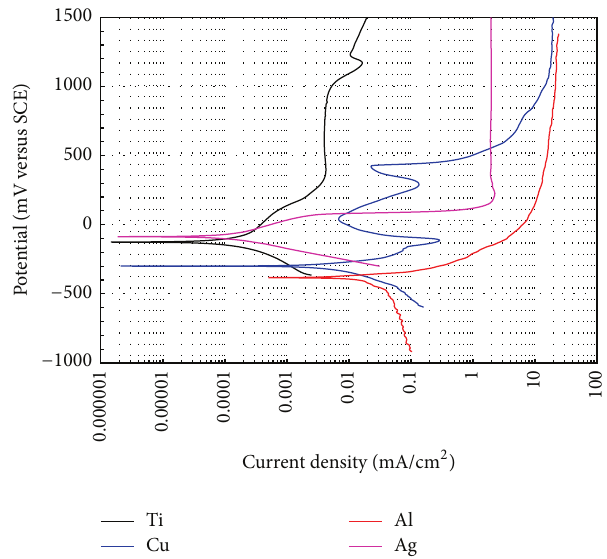
Figure2:Polarizationcurvesforthepureelementsinartificialsaliva at 37 ∘ C (d 𝐸 /d 𝑡 =